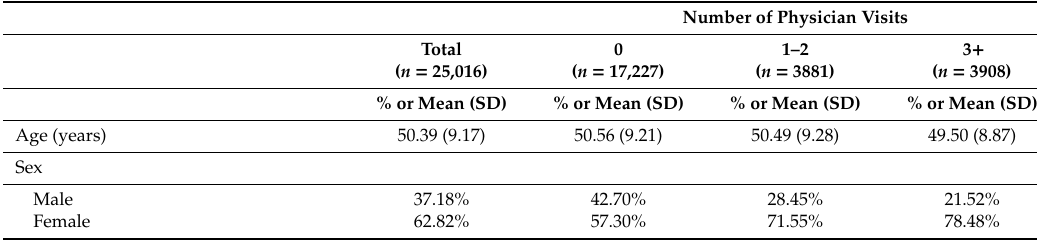
Table 1. Baseline characteristics of ATP participants ( n =